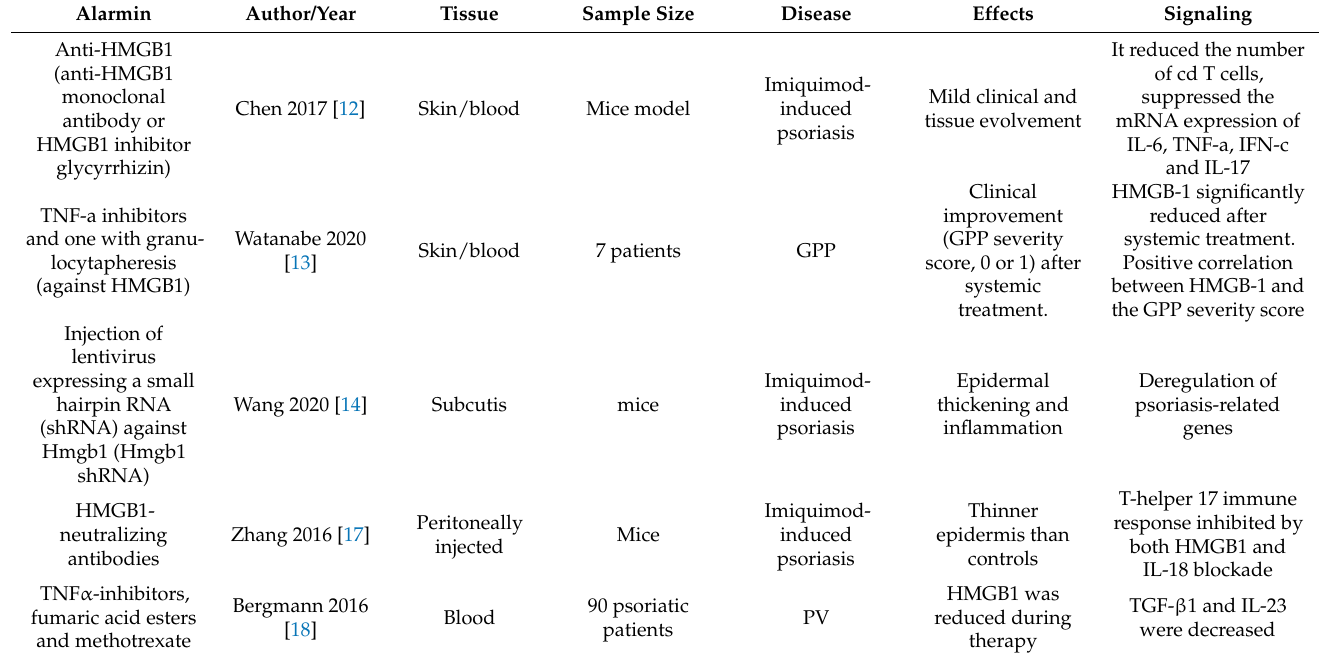
Table 2. Effects of HMGB1 neutralizing by experimental approaches or conventional therapies in